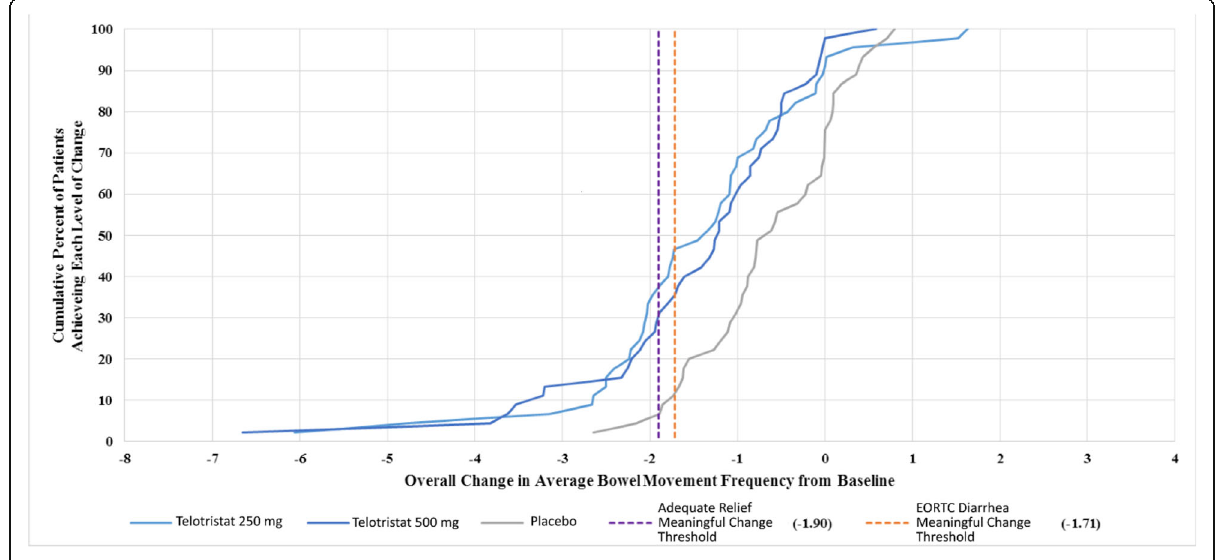
Fig. 3 CDF of Overall Change from Baseline in Average BM Frequency